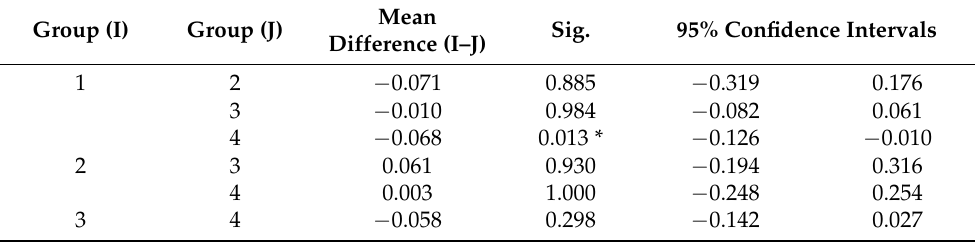
Table 7. Multiple comparisons of mixed media on perceived social support.